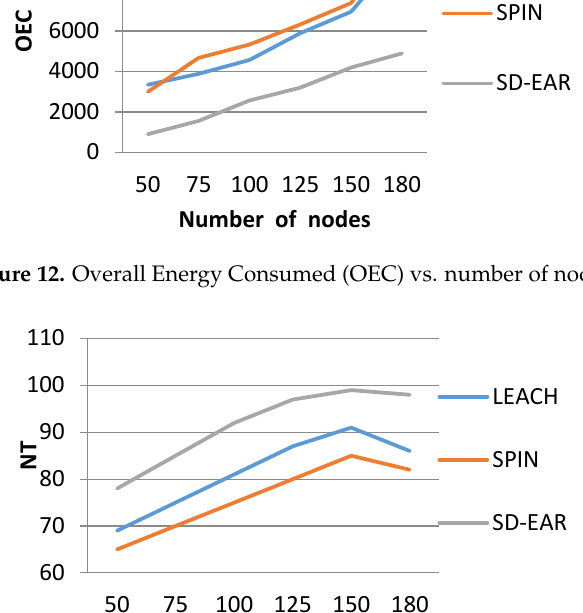
Figure 13. Network Throughput (NT) vs. number of nodes.